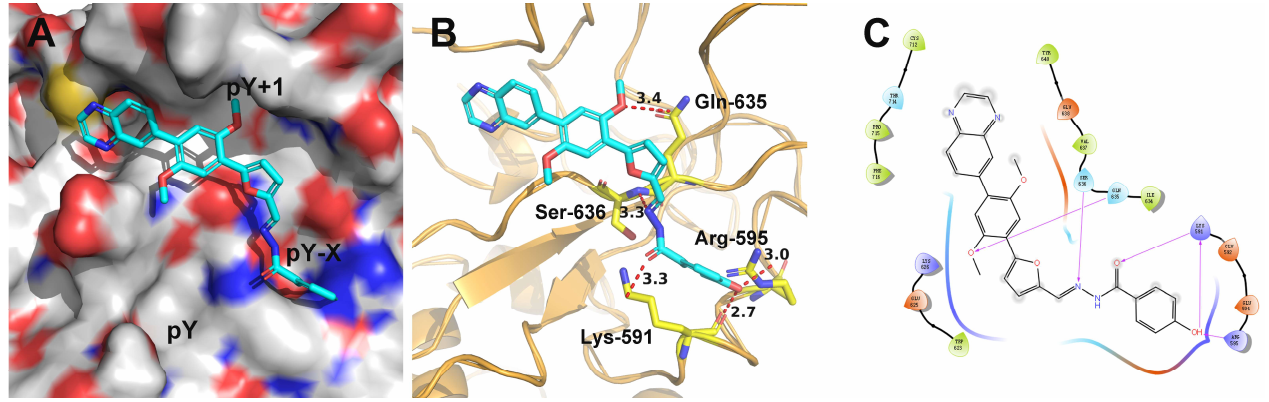
Figure 10. Molecular docking results. ( A ) Docked conformation of QW12 in the active site of STAT3. ( B ) 3D model of QW12 bonded to the active site of STAT3. ( C ) 2D model of the interactions between amino acid residues and QW12 . The docking model between compound QW12 and the SH2 domain of the STAT3 protein (PDB: 1BG1) was produced by Schrodinger software.